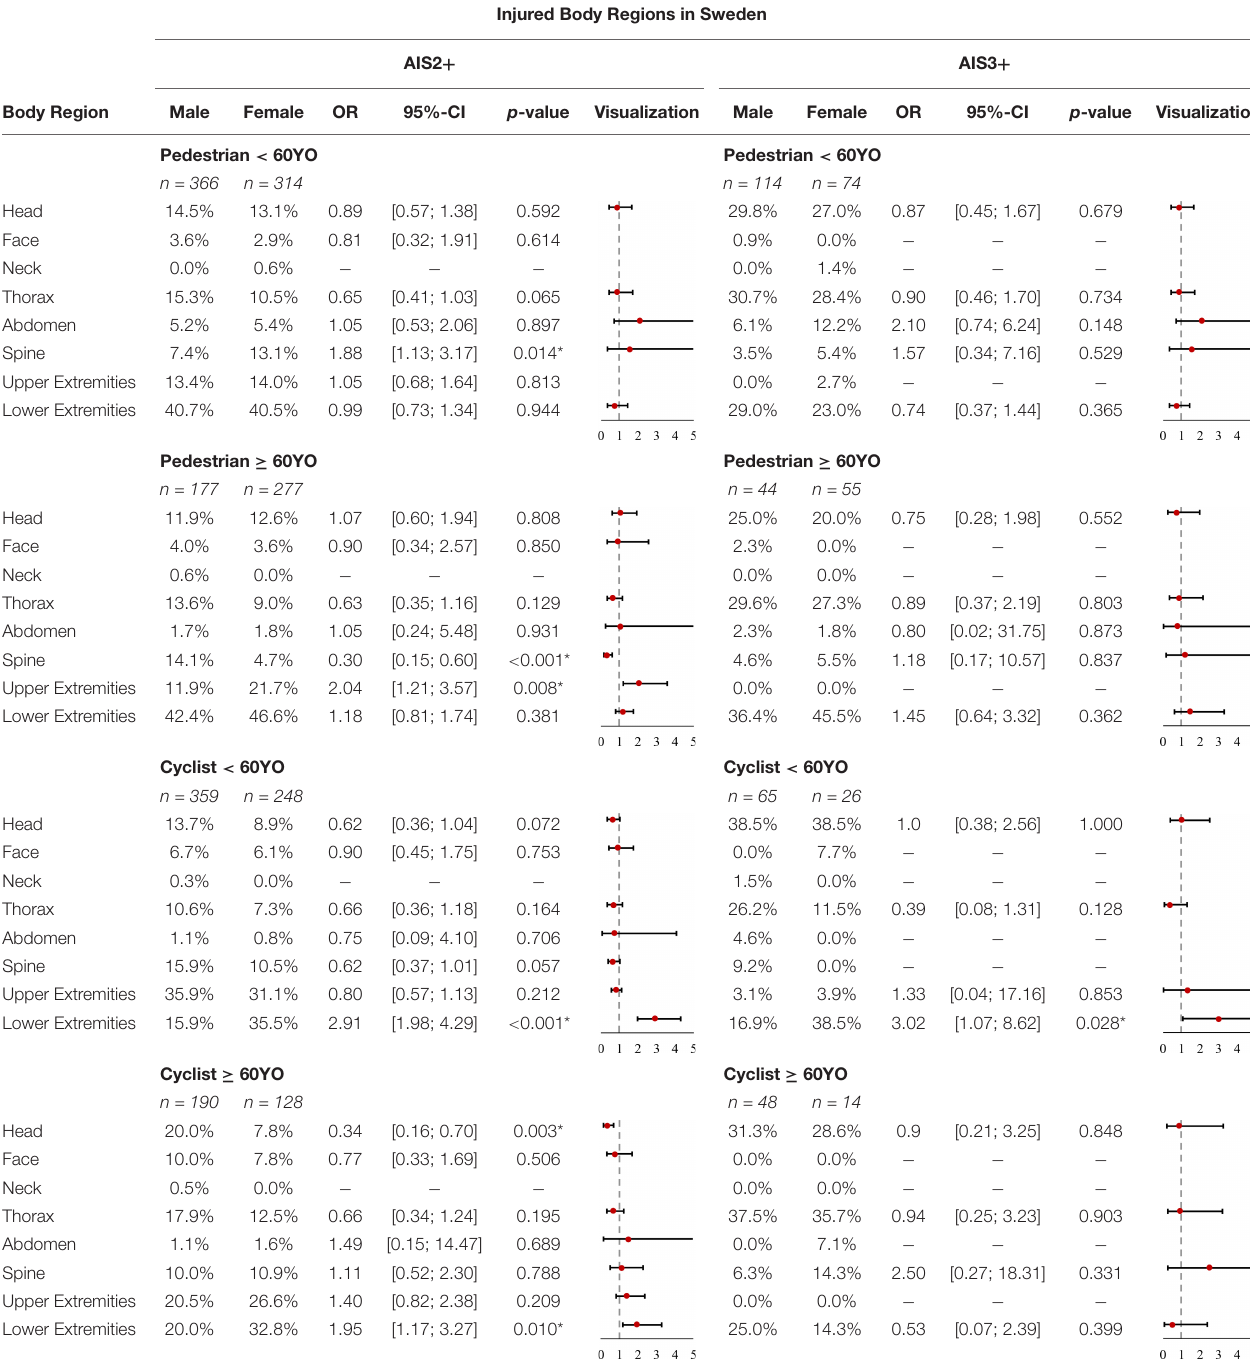
TABLE 6 | Share of injured body regions for AIS2 + and AIS3 + injuries, OR and p-value in Sweden for pedestrians and cyclists < 60YO and ≥ 60YO (* p -value < 5%). Injured Body Regions in